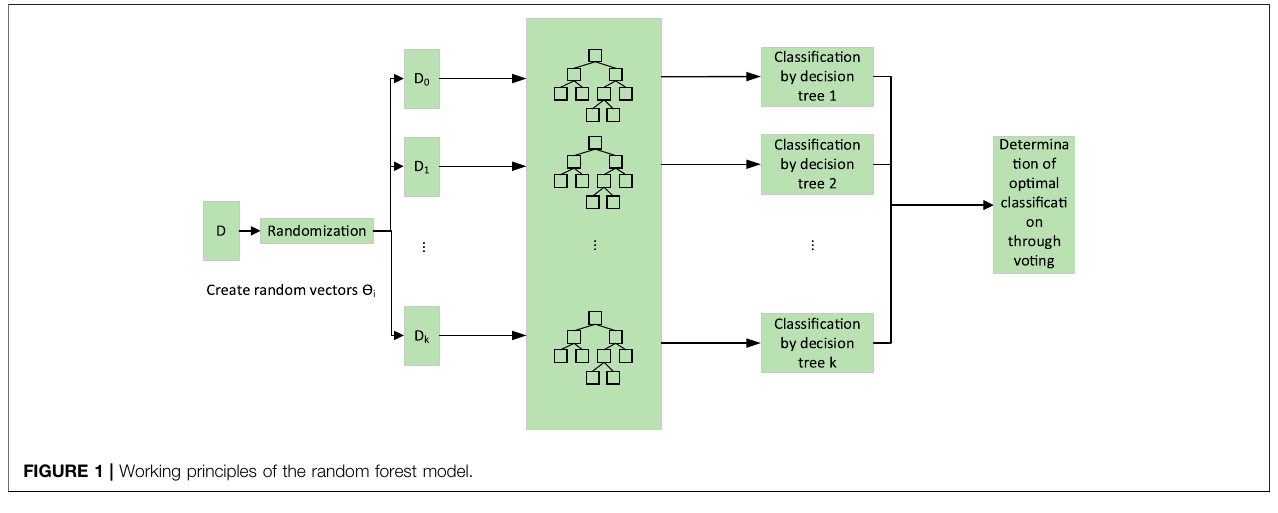
FIGURE 1 | Working principles of the random forest model.